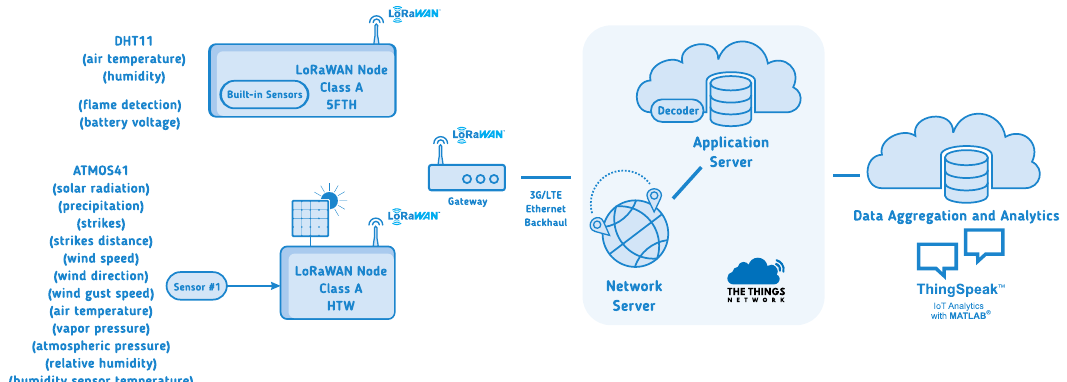
Figure 11. Overview of the implemented system.